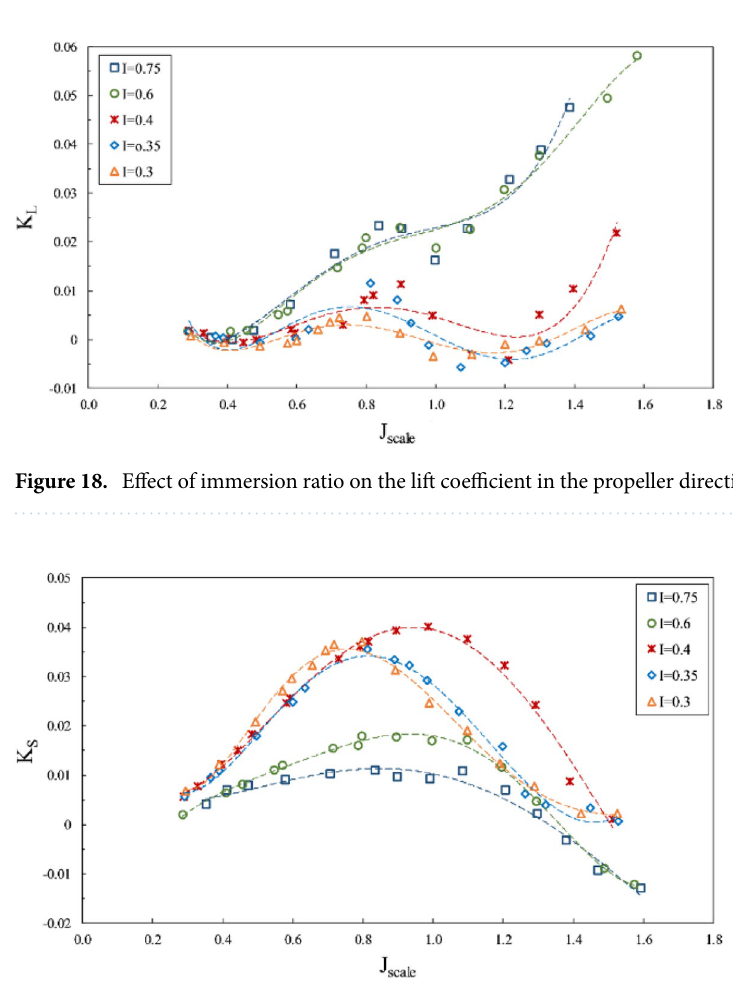
Figure 19. Effect of immersion ratio on the side force coefficient in the propeller direction ( α = 6 ◦